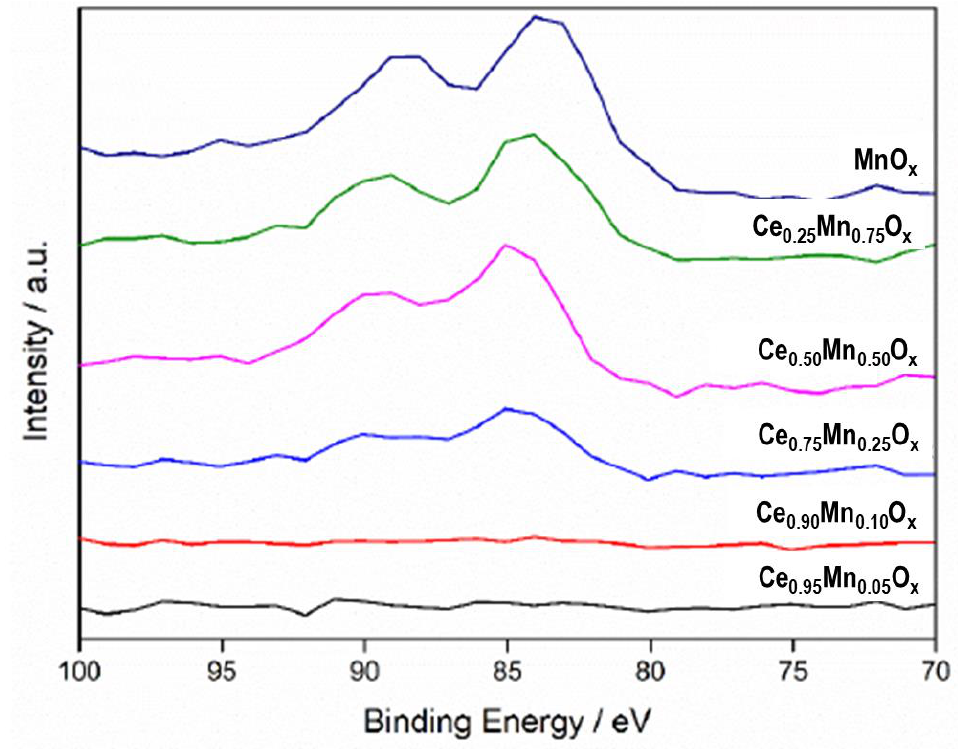
Figure 6. Mn 3s XPS spectra for ceria-manganese mixed metal oxide catalysts prepared by co-precipitation with sodium carbonate.